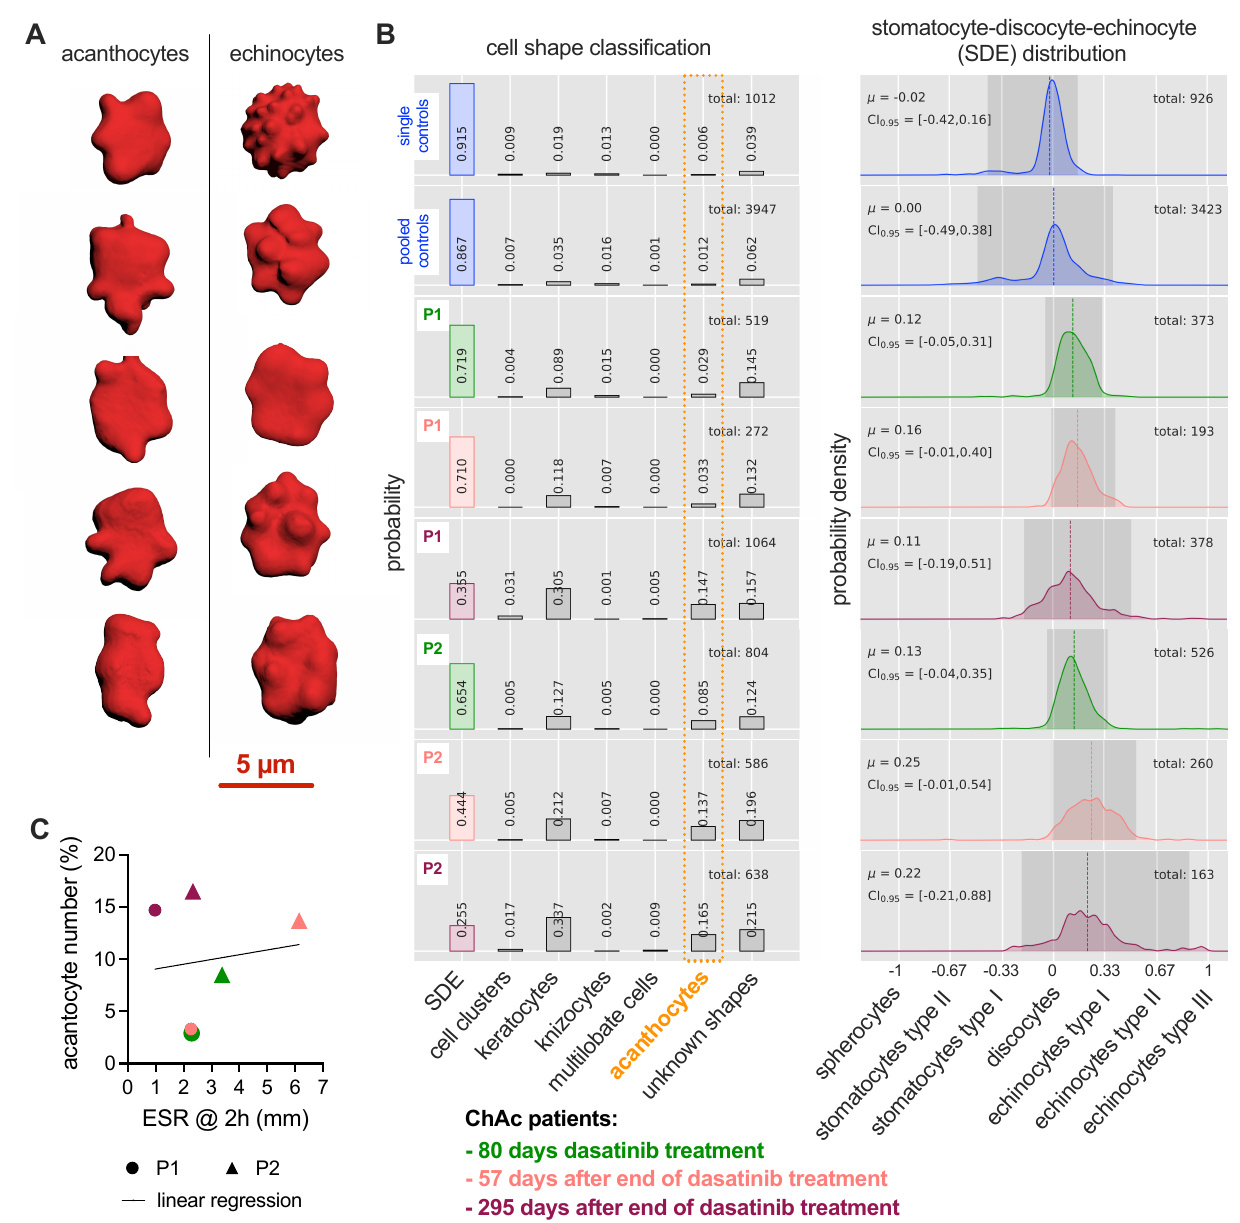
Figure 3. Classification of RBC morphology by an artificial neural network (ANN). ( A ) Panel A shows 3D-rendered RBCs based on confocal stack recordings. We present the comparison of acanthocytes on the left and echinocytes on the right, as classified by the ANN. ( B ) Panel B depicts the quantification of the morphological classification for a representative healthy control, a pooled control of 10 donors and the two ChAc patients for the three sampling time points. ( C ) In panel C, the acanthocyte number is plotted against the ESR for the two ChAc patients. There is no correlation between the parameters (slope of the linear regression is not significantly different from zero ( p =